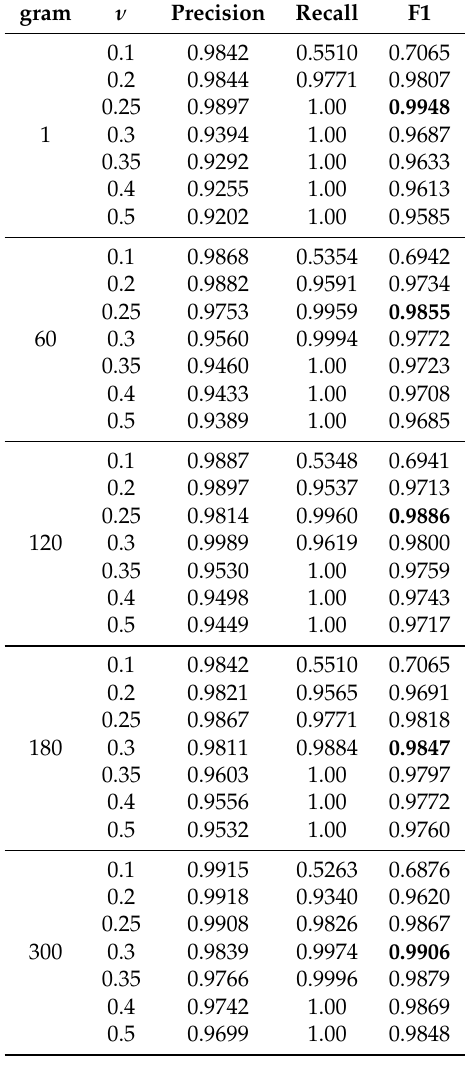
Table 2. Precision, recall, and F1-score of different gram and ν parameters on OCSVM. Best performance of the F1-score is highlighted in